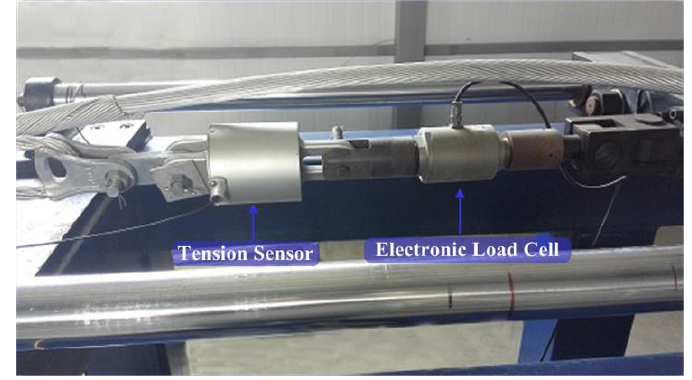
Figure 10. The connection diagram of tension sensors.